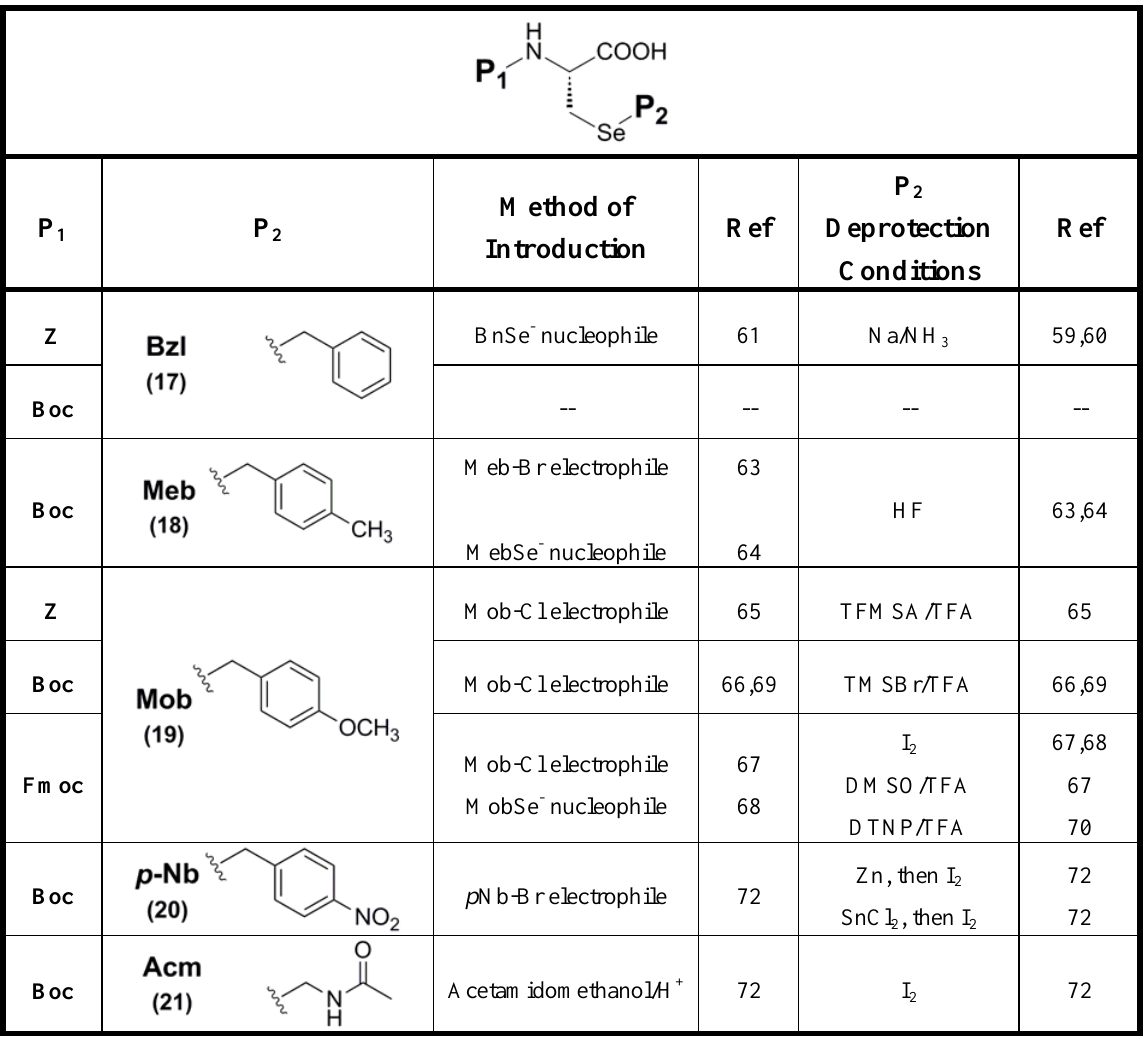
Table 2. Known selenocysteine protection